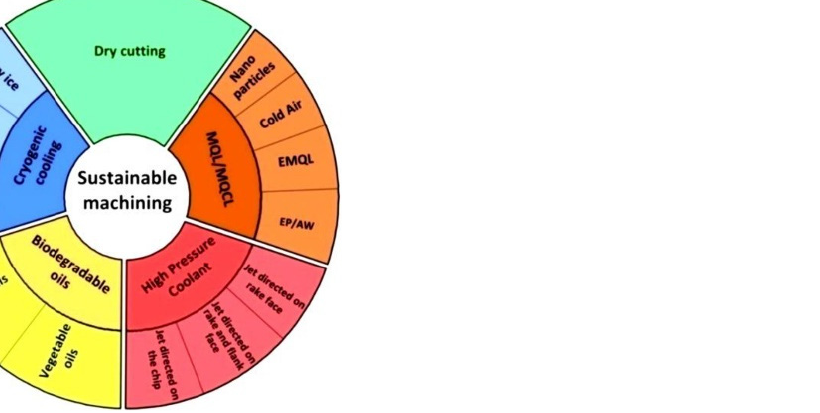
Figure 2. Ring of sustainable machining, reproduced from [50,73], with permission from Elsevier, 2020 and 2019.